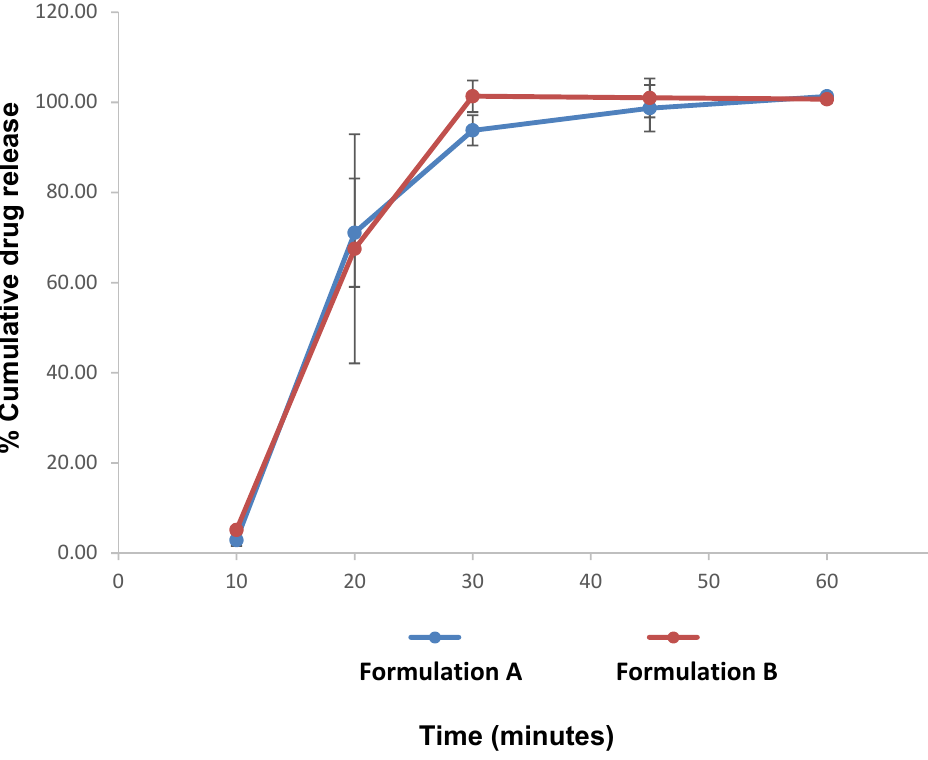
Figure 6. Dissolution profile of Formulation A (AB non-masked mini-tablets) and Formulation B (AB masked mini-tablets).